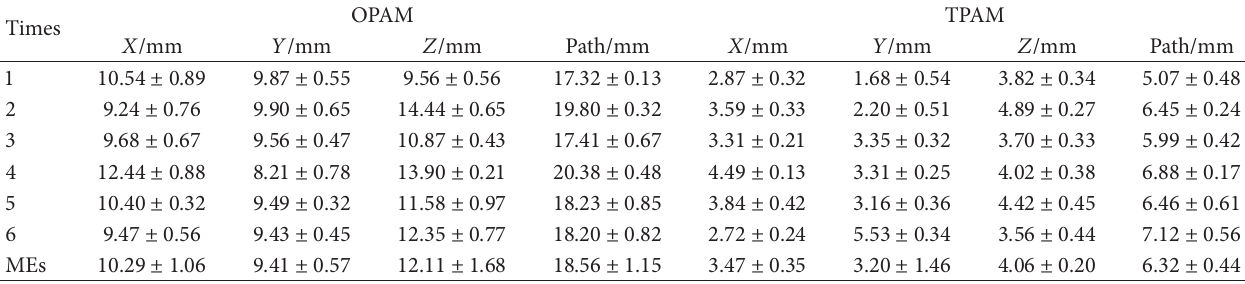
Table 3: Mean absolute errors (MAEs) for 6 tests measured by the robot in the period of approaching.